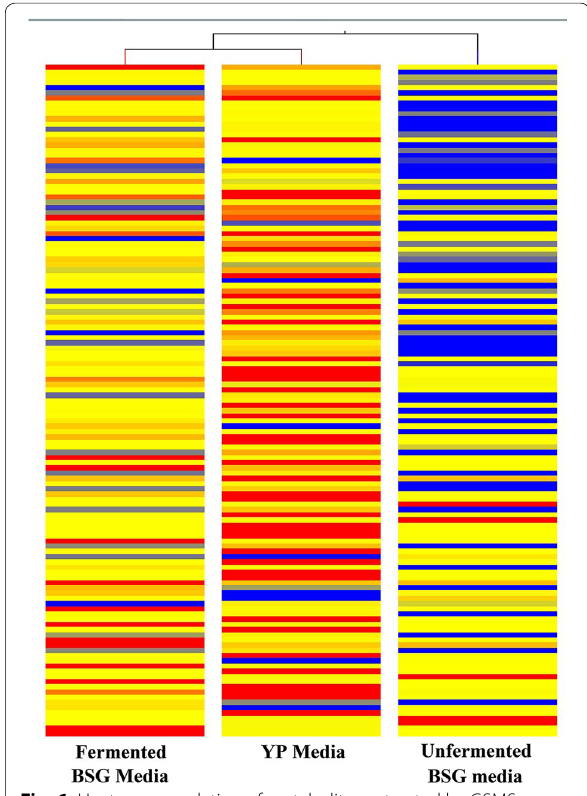
Fig. 6 Heatmap correlation of metabolites extracted by GSMS spec- tra in YP media, unfermented BSG media and fermented BSG media. Metabolites shaded in red are up regulated while those in blue are down regulated in terms of abundance